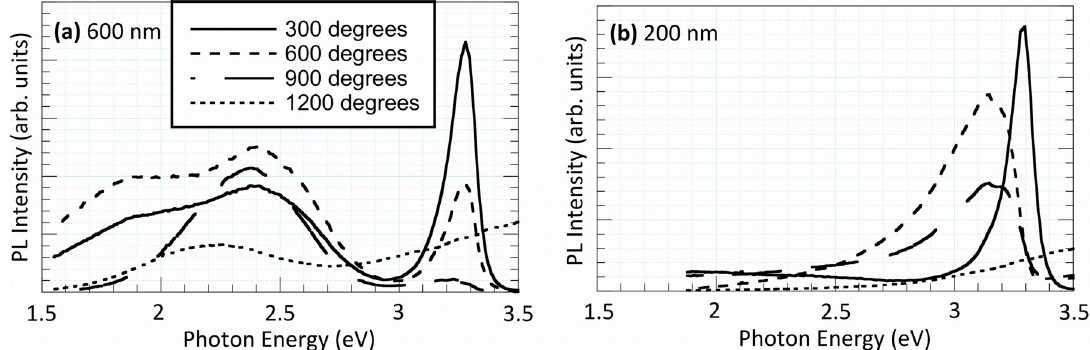
Figure 2. PL spectra of ZnO films grown at 300 ◦ C, 600 ◦ C, 900 ◦ C and 1200 ◦ C at thicknesses of ( a ) 600 nm and ( b ) 200 nm. For thicker films, increasing green band emission relative to UV emission is seen with increasing temperature. Thinner films demonstrate little green band emission; however, a significant redshift in UV emission and asymmetrical band broadening is observed at higher